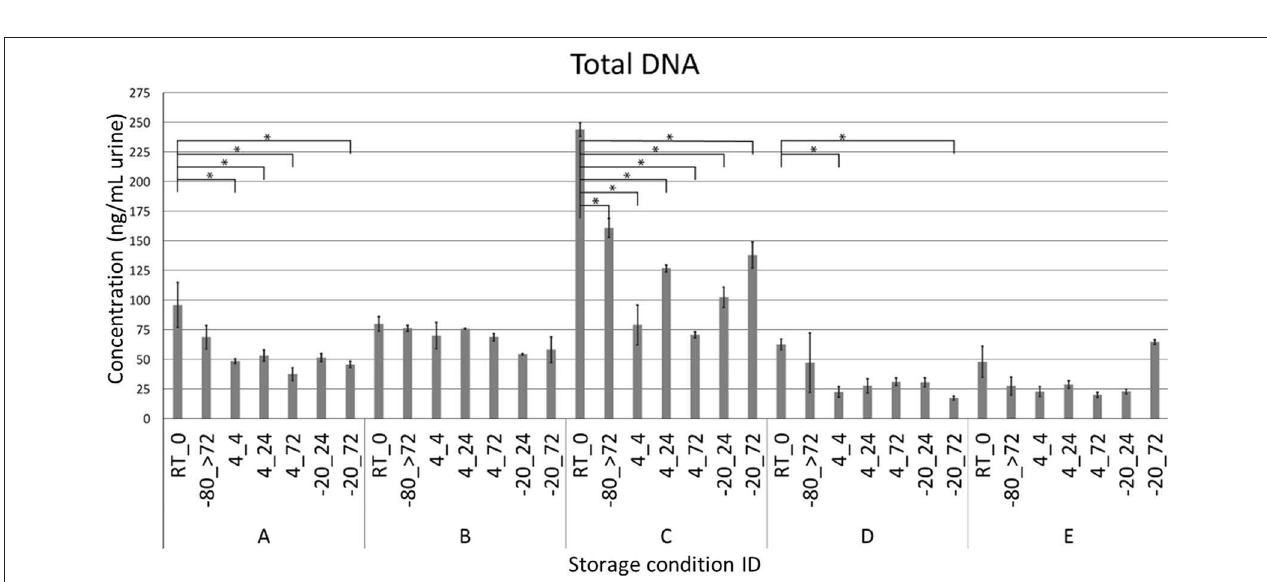
FIGURE 2 | DNA yield. Quantity of total DNA purified from voided urine shown for each donor (A–E) and storage condition. Each sample is named as “temperature_duration.” * P < 0.05. RT = room temperature, > 72 = sample are stored for at least 72h.